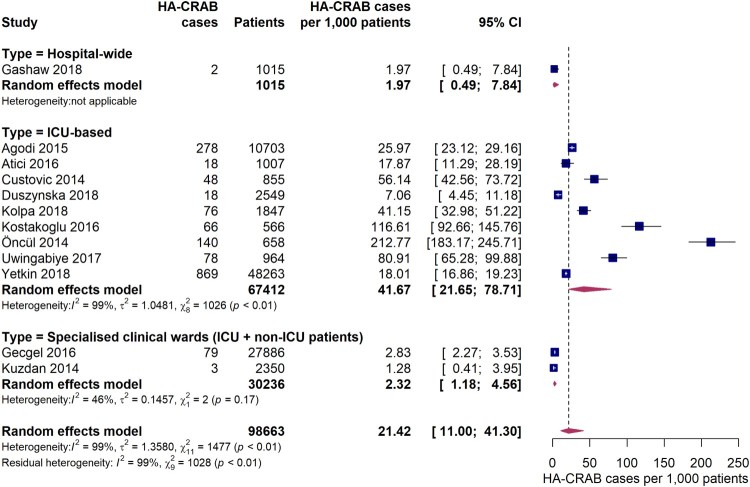
Forest plot of studies on the incidence of hospital-acquired carbapenem-resistant Acinetobacter baumannii infections. Abbreviations: HA-CRAB: hospital-acquired carbapenem-resistant Acinetobacter baumannii, ICU: intensive care unit, 95% CI: 95% confidence interval.